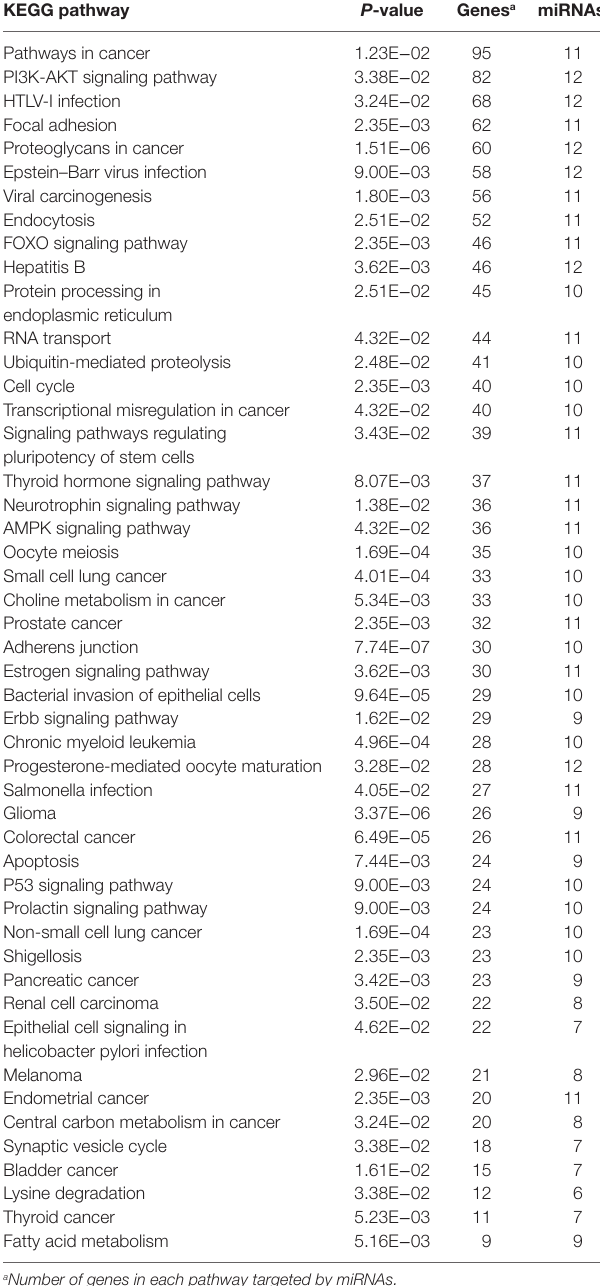
TaBle 4 | Gene ontology terms for biological processes of target genes of 16 microRNAs (miRNAs) differentially expressed in cells treated with serum from healthy individuals compared with head and neck squamous cell carcinomas (HNSCC) patients.